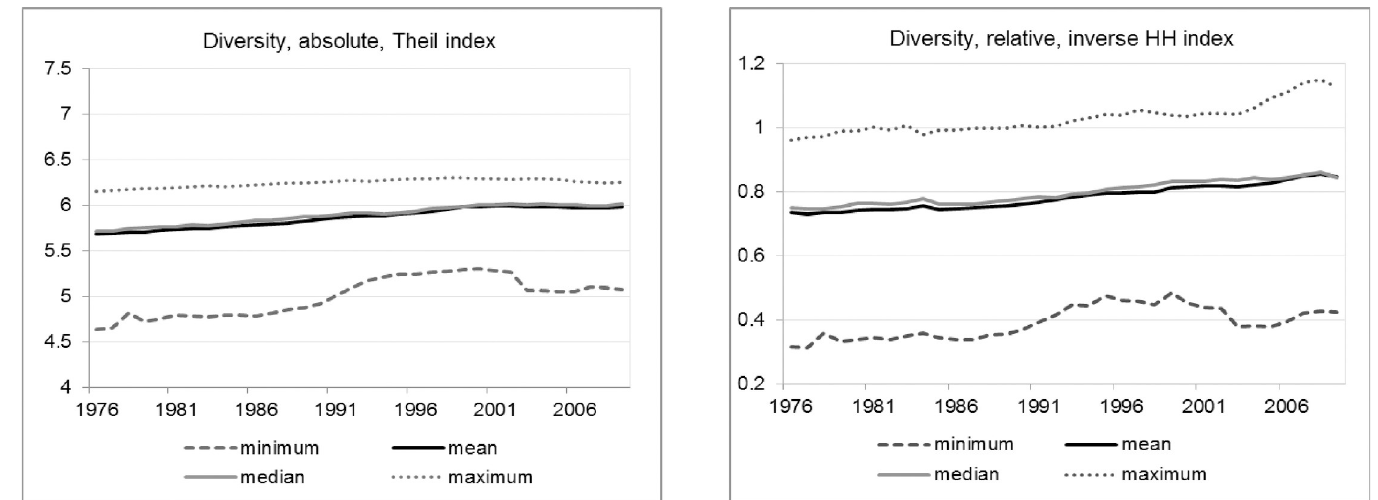
Fig 1. Evolution of absolute and relative diversity over time. Source: Authors.